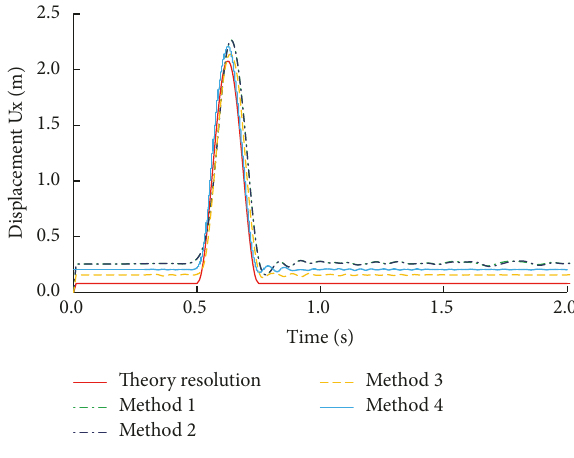
Figure 17: X component displacement of Point E.